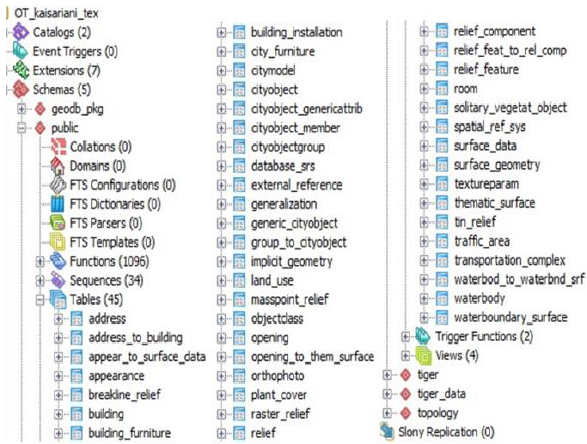
Figure 5. Schema Structure of 3DCityDB